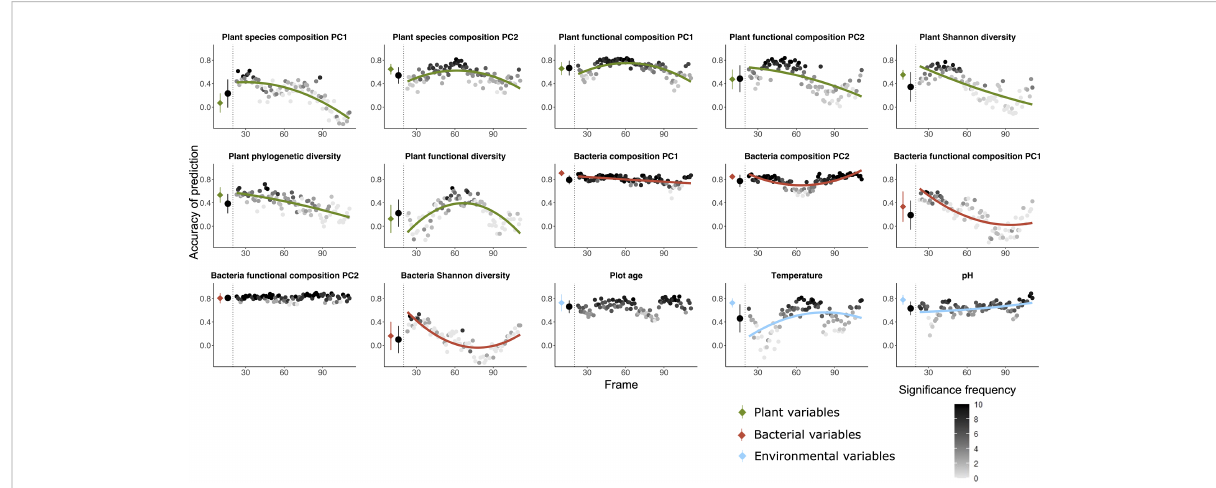
FIGURE 2 Random forest predictions using the community table of soil fungal communities (OUT table) as explanatory variable to predict seven variables of plant (green), fi ve variables of bacteria (red) as well as three variables of environmental factors (blue) as dependent variables. The prediction was done both using all the 135 plots and using a moving frame approach. For the moving frame approach, every 45 plots were grouped into one frame and the median plot was used as identi fi er of the frame. Thus, the fi rst frame included plots 1 to 45, the second 2 to 46, and so forth. The x axis represents the median plot of every frame whose identi fi ers ranged from plot 23 to plot 113 (i.e. from young successional plots to old plots). The colored circles at the left of each plot denote the mean ± standard deviation of the accuracy of prediction (Pearson ’ s r) using the full dataset (results of 10-fold cross validation), and the black circles denote the mean ± standard deviation of the accuracy of prediction for all the frames. Each grey to black circle on the right of each plot represents the mean accuracy of prediction of each frame and the color gradient is showing how many correlations of the 10-fold cross-validation were signi fi cant with lighter colors indicating less frequent signi fi cant predictions. A quadratic or linear regression (the model with higher adjusted r 2 value) is fi t for the gradient if it is signi fi cant, showing a change of the accuracy of prediction along the successional